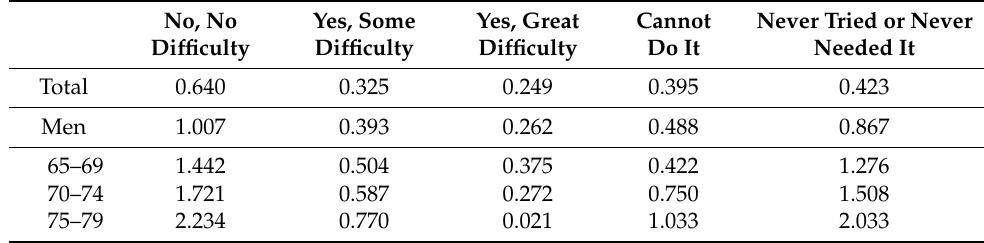
Table A1. Difficulty in preparing meals. Sampling errors of row percent by sex and age